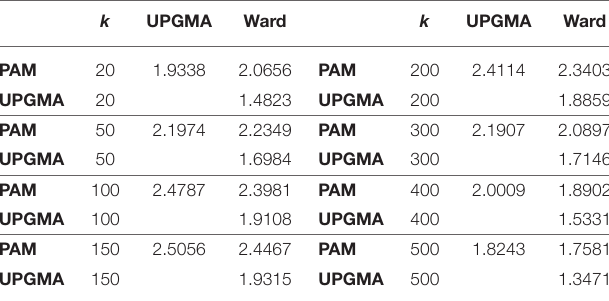
FIGURE 1 | The cluster maps (A–C) , stability maps (D–F) , and the stability histograms for the three clustering methods PAM (left), UPGMA (center), and Ward’s (right) method, calculated for k = 150 clusters. Clusters in maps (A–C) are presented on a diverging scale of 15 colors, which repeat. Stability maps (D–F) also contain candidate survey sites selected based on linguistic centrality within their own cluster. Large differences are visible across the cluster solutions and smaller differences across the stability of the clusters. Besides, stability shows little spatial autocorrelation beyond the large size of clusters found by UPGMA.